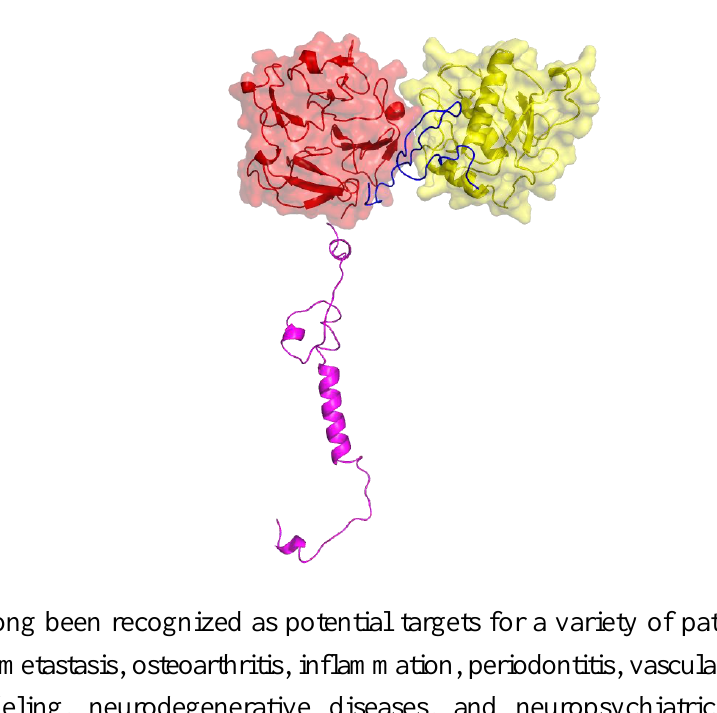
Figure 4. Three-dimensional structure of MT1-MMP. The catalytic (CAT) domain is yellow, the linker/hinge is blue, the hemopexin-like (HPX) domain is red, and the transmembrane and cytoplasmic domains are purple. The structure is based on X-ray crystallographic analyses of MT1-MMP CAT and HPX domains [10,11] and modeling of the transmembrane and cytoplasmic domains by I-TASSER